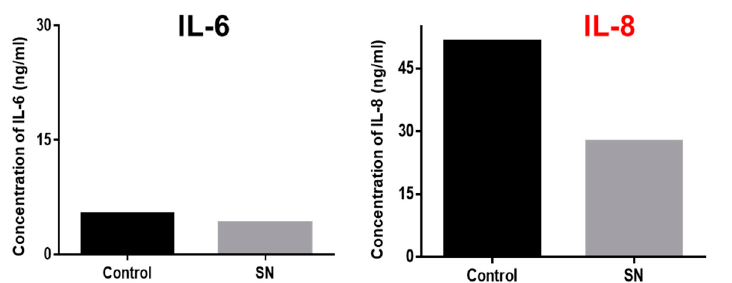
Figure 6. E ff ect of sulconazole on the NF- κ B and IL-8 signaling pathways. ( A ) Cancer cells were treated with sulconazole for 24 h. Nuclear proteins were resolved on a 10% SDS-PAGE gel, followed by western blotting with anti-pStat3, anti-Stat3, anti-p65, and anti-Lamin B antibodies. ( B ) An electrophoretic mobility shift assay (EMSA) was used to assess nuclear lysates from mammospheres treated with sulconazole. The nuclear proteins were incubated with an IRDye 800-NF- κ B probe and separated by 6% PAGE. Lane 1: probe only; lane 2: nuclear proteins with probe; lane 3: sulconazole-treated nuclear proteins with probe; lane 4: 10 × self-competition. The arrow indicates the DNA / NF- κ B interaction in the nuclear lysates. ( C , D ) Transcriptional levels of the IL-6 and IL-8 genes were determined in sulconazole-treated mammospheres and p65-knockout samples treated with a siRNA specific for p65. IL-6- and IL-8-specific primers were used for real-time RT-PCR. β -actin acted as an internal control. The data are presented as the mean ± SD; n = 3 independent experiments; * p < 0.05 vs. the control. ( E ) The cytokine profiles of conditioned media from mammosphere cultures were determined with cytokine-specific antibodies and cytokine beads. Sulconazole reduced extracellular IL-8 levels in the mammosphere cultures.